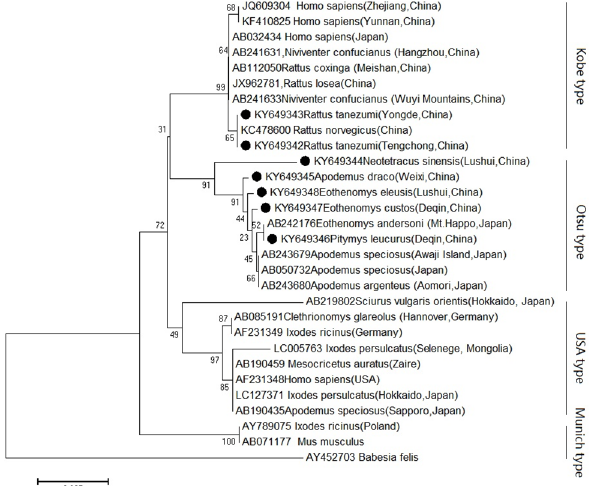
Fig 1. Neighbor-joining phylogenetic tree based on a comparison of Babesia microti 18S rRNA gene sequences obtained from Yunnan small mammals with Babesia microti referencestrains. Babesia felis was includedas the outgroup.The numberon each branch shows the percent occurrencein 1,000 bootstrapreplicates. Black circles stood for novel sequencesidentified in this study.